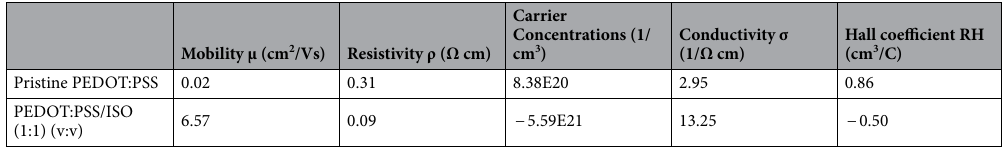
Table 1. Room temperature Hall-effect data of pristine and isopropanol-treated PEDOT:PSS (1:1) (v:v) films.